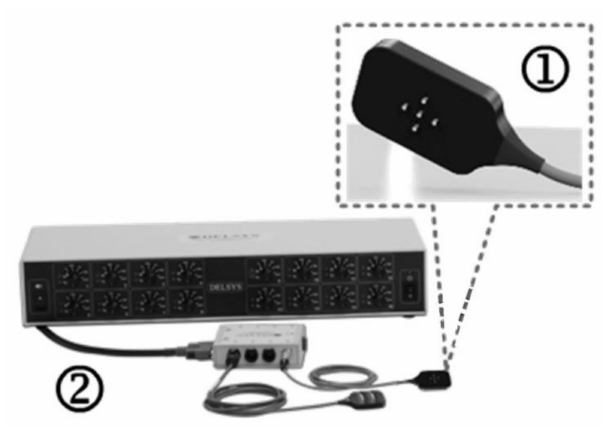
Figure 2. dEMG sensor ( 1 ); Delsys Bagnoli amplifier ( 2